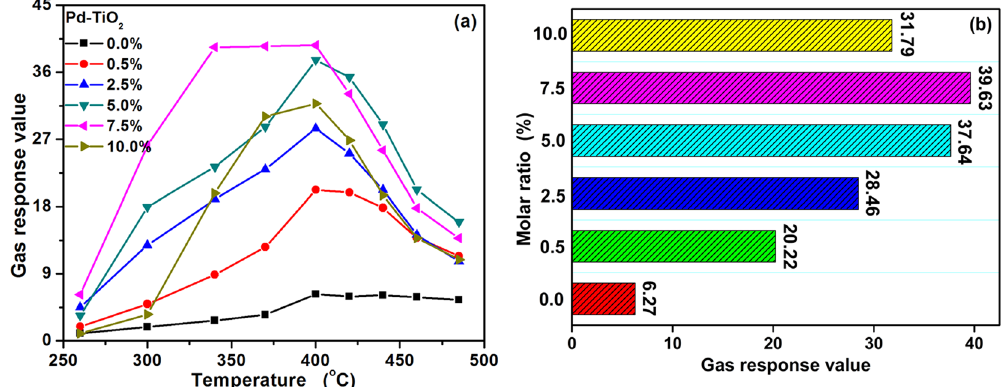
Figure 5. Gas responses of the sensors based on pure and different molar ratios of Pd functionalized TiO 2 nanoparticles at different operating temperature toward 3000 ppm butane, and ( b ) the butane response of different mole percentage of Pd functionalized TiO 2 nanoparticles fabricated sensors at the optimum temperature of 400